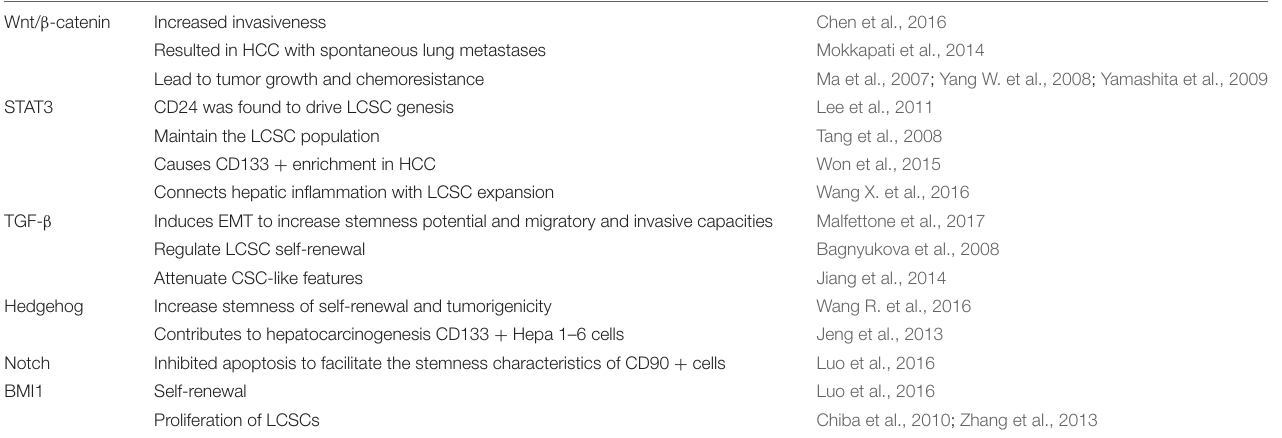
TABLE 1 | Signaling pathways activated in